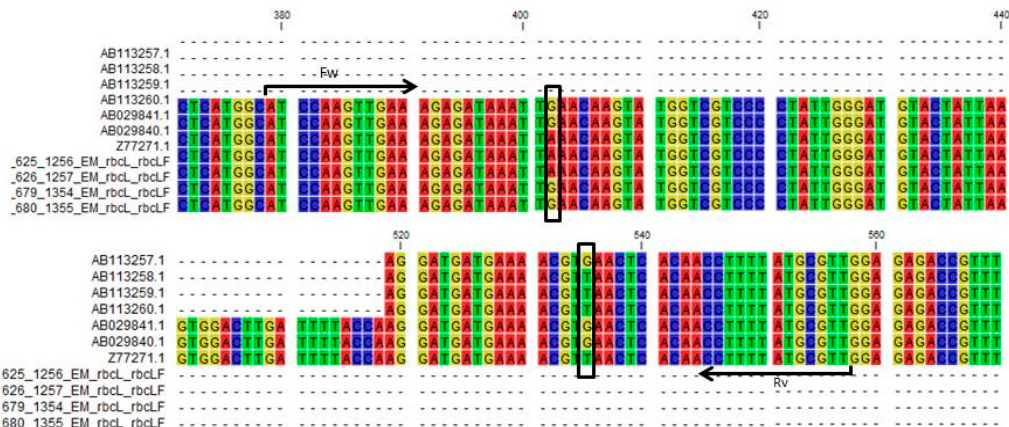
Figure 3. Graphical representation of the location of genus - specific primers. The figure shows a multiple alignment with 4 Liriope and 4 Ophiopogon rbcLa consensus sequences joined to the rbcLb sequences published by Ito et al. (2012) using three rbcL sequences from the database that bridge the rbcLa and rbcLb regions. The black arrow indicates where the forward and reverse primers were designed. The black boxes indicate the two SNPs incorporated into the 3 ′ position of the primer sequences.